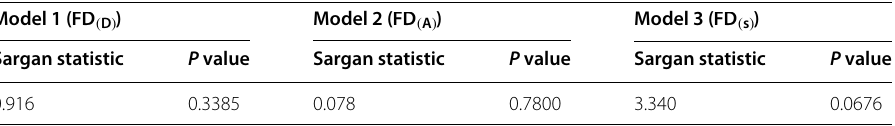
H 0 instruments are valid (fail to reject H 0 ) at the 1% and 5% levels,